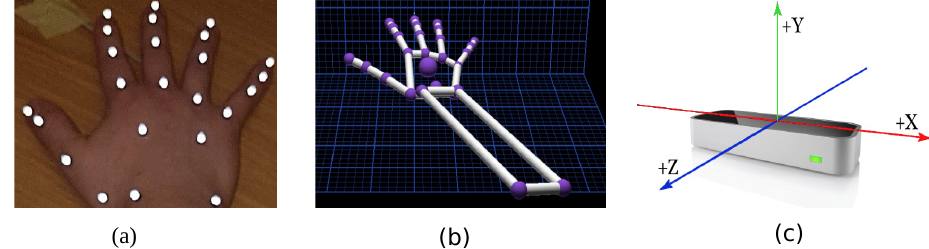
Figure 1. This figure shows the representation of the components used for the experiment. ( a ) Placement of the markers on the hand; ( b ) shows the skeletal hand model from the LMC; and ( c ) shows the LMC device with the axis orientation, which is the same for